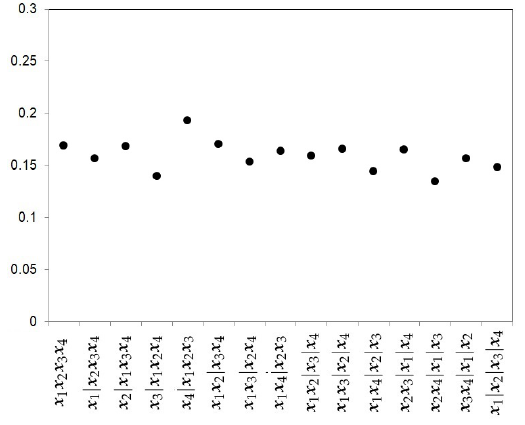
Figure 10. Posterior mean of the meta–parameter θ for each